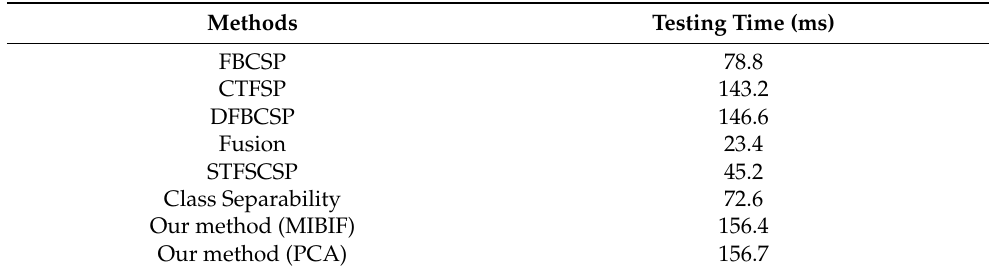
Table 7. Comparison of average computational time for testing one trial with different competing methods for subject